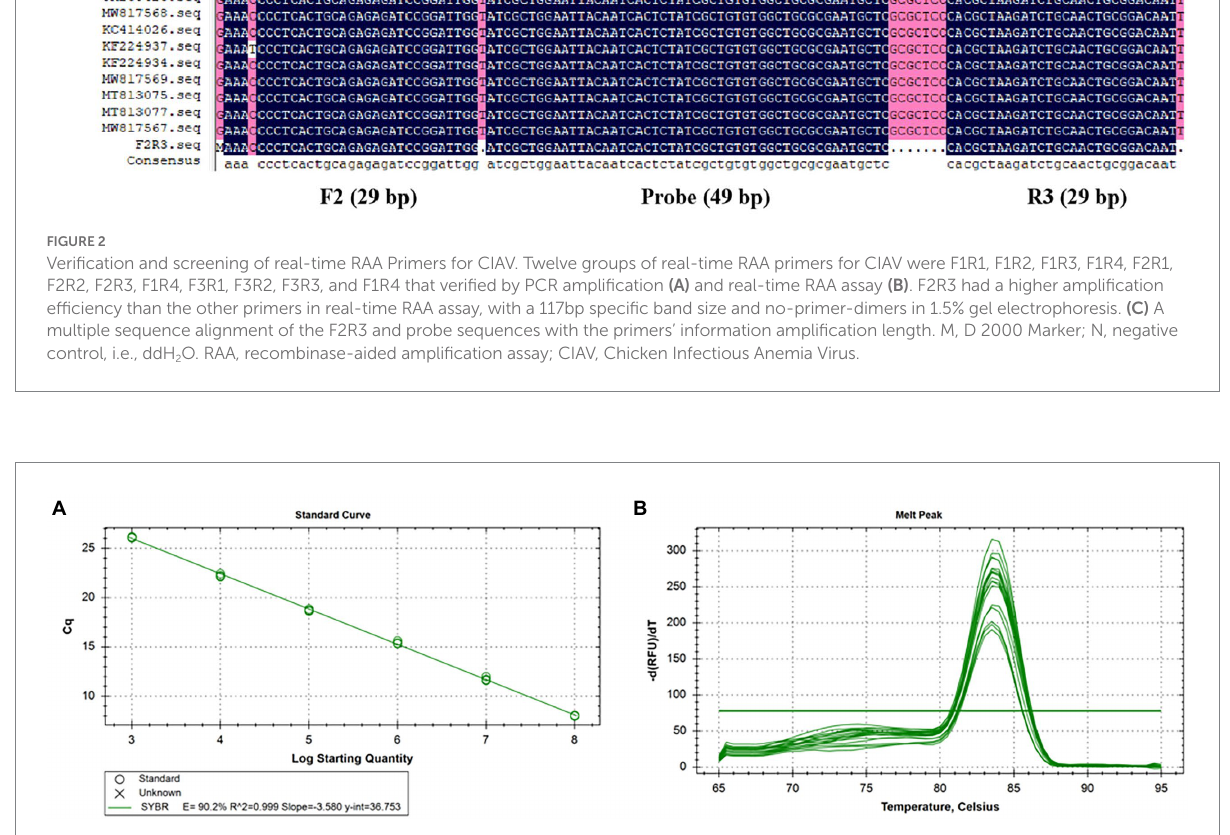
FIGURE 3 Standard curve and melting curve of real-time qPCR for CIAV. (A) The logarithmic function relationship between cycle threshold and plasmid copy number was y = − 3.580x + 36.753, R 2 = 0.999, and efficiency was 90.2%. (B) The melt temperature of real-time qPCR for CIAV was 83.5 ° C. CIAV, Chicken Infectious Anemia Virus; qPCR, quantitative polymerase chain reaction